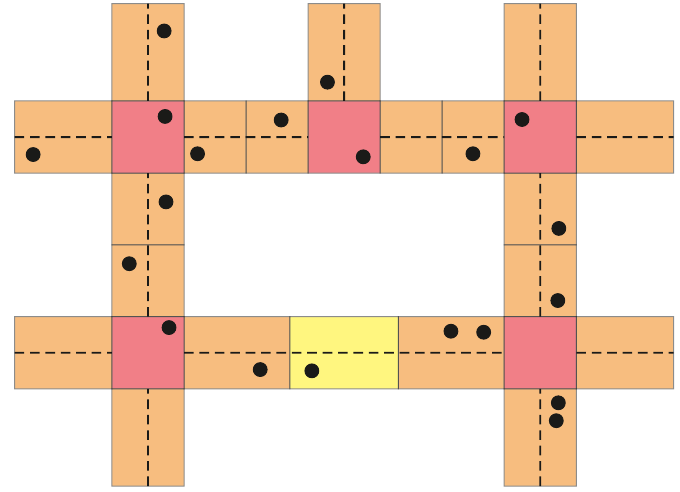
Figure 2. The intersection-based layout of the VaNetLayer (the circles represent